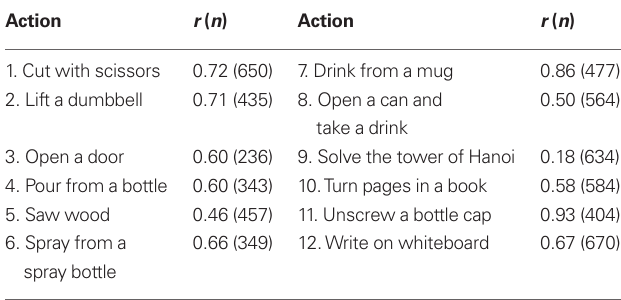
Table 6 | Correlation coefficients (Pearson r ) for the relationship between the density functions for the picture and no-picture-inverted groups.